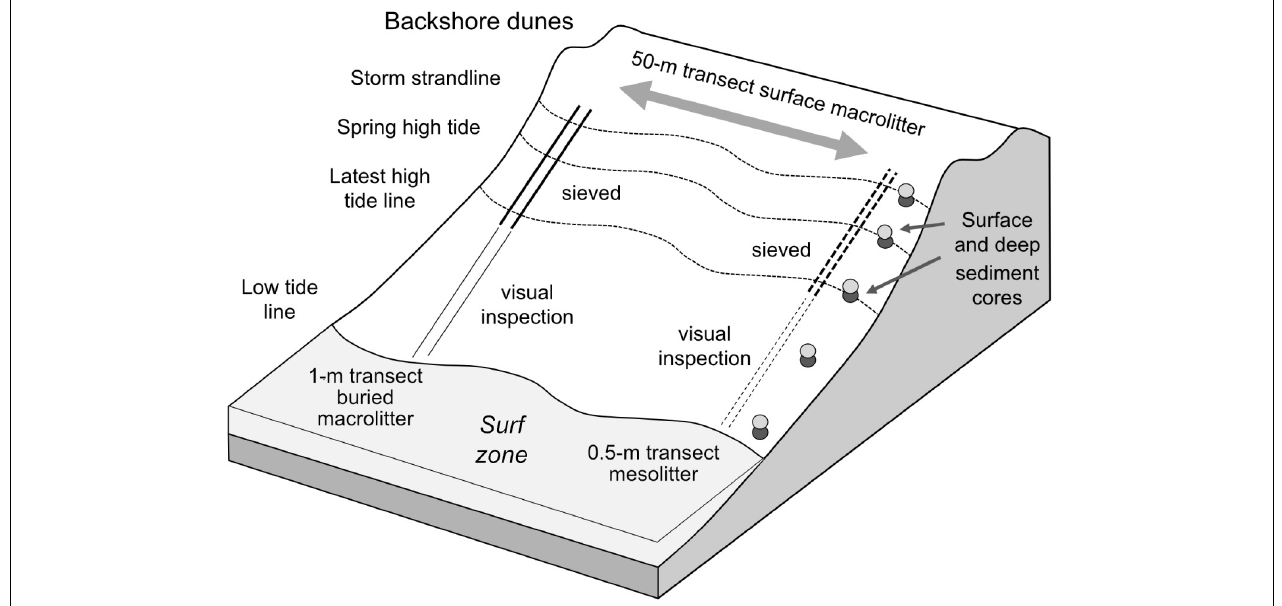
FIGURE 1 | Schematic diagram of sampling protocols, combining 50-m transects for surface macro-litter, 1-m coarse-sieved samples for buried macro-litter, 0.5-m fine sieved samples for meso-plastics, and paired sediment cores (shallow and deep) at five sites across the beach profile for